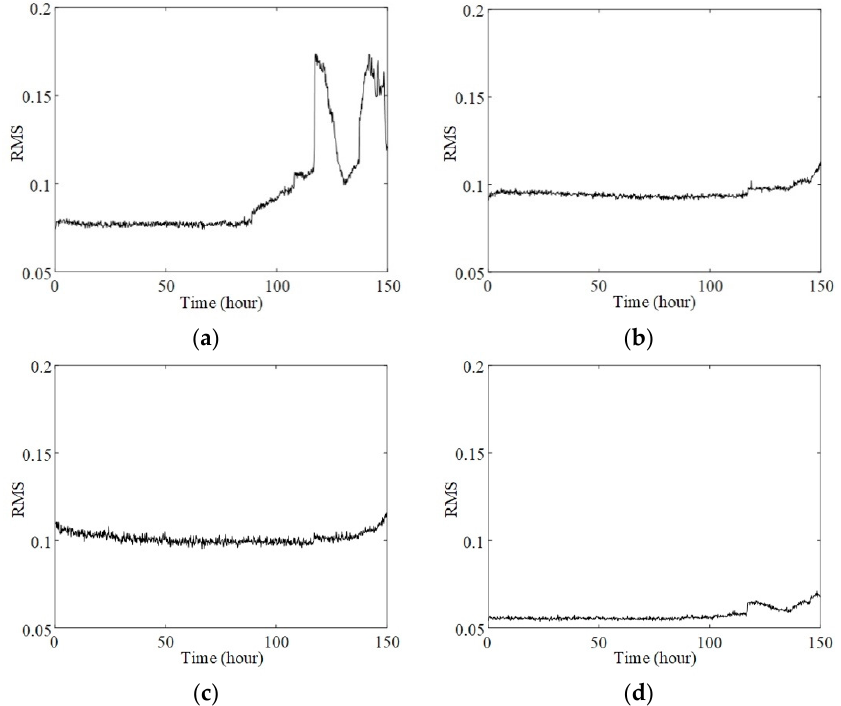
Figure 9. Root mean square (RMS) of vibration signals: ( a ) bearing 1; ( b ) bearing 2; ( c ) bearing 3; ( d ) bearing 4.